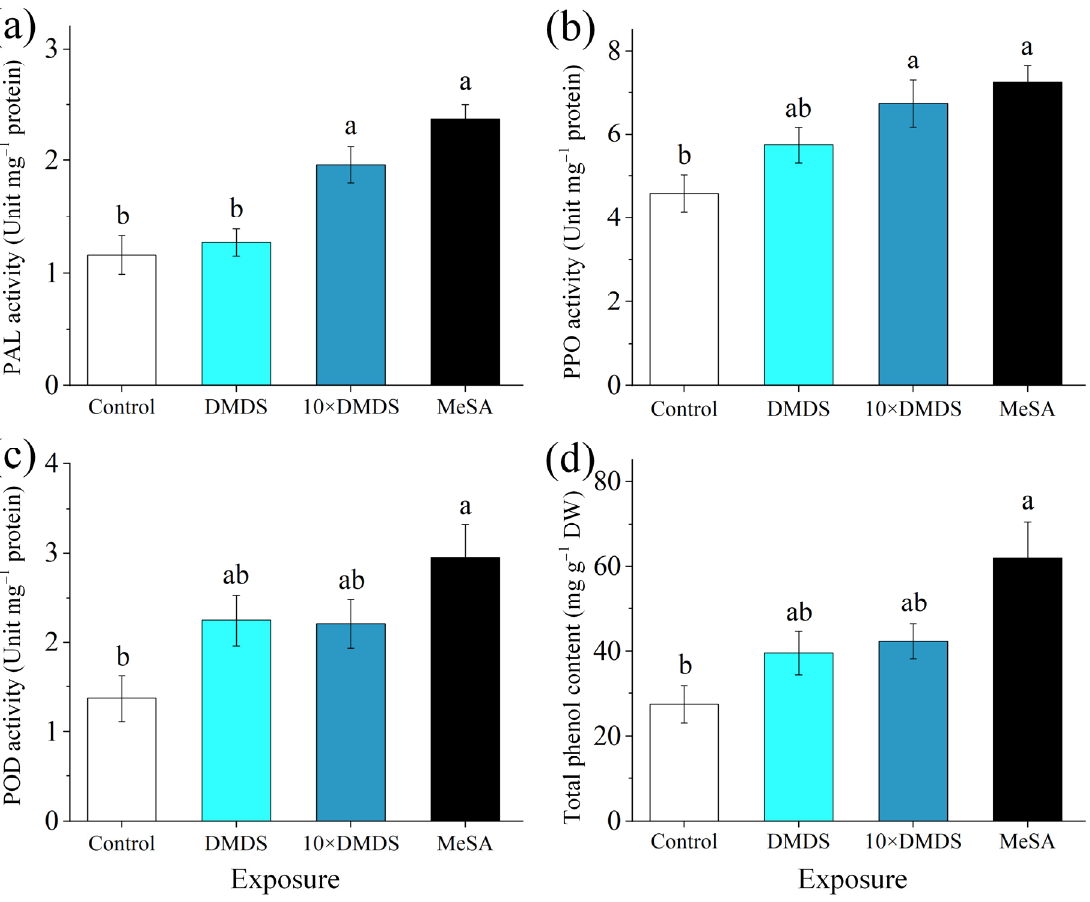
Figure 5. Phenylalanine ammonia lyase (PAL), polyphenol oxidase (PPO), and peroxidase (POD) activities and total phenol content of orange plants after exposure to dimethyl disulfide (DMDS). ( a – c ) PAL, PPO, and POD activities, respectively; ( d ) total phenol content. Data are shown as means ± SE ( n = 3). Different letters on the columns indicate significant differences among different treatments based on Tukey’s test ( p < 0.05).